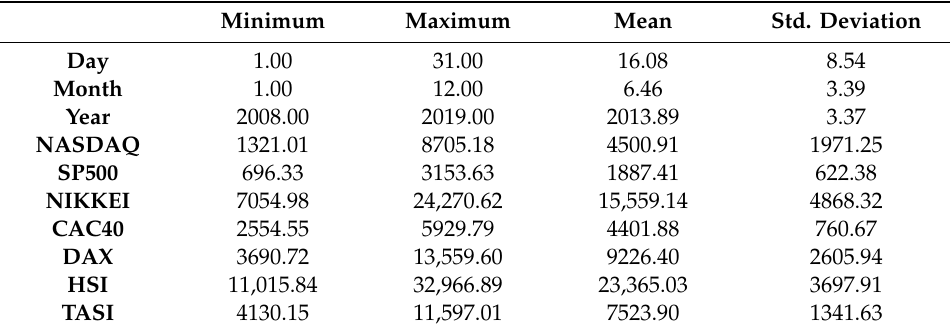
Table 2. Statistical description of international stock market